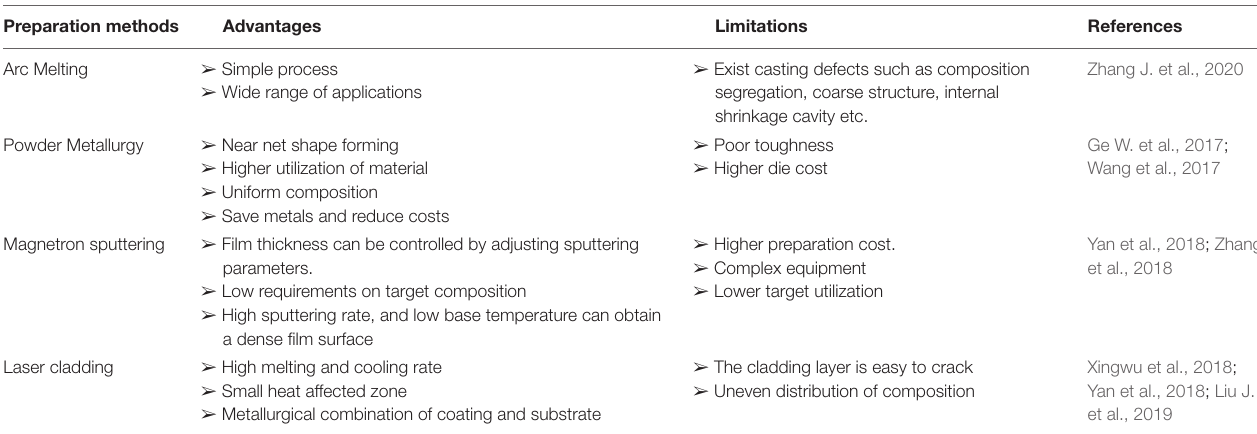
TABLE 1 | The advantages and limitations of HEAs